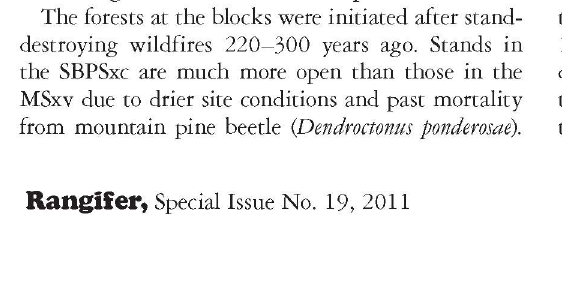
subzones, lodgepole pine is the dominant tree spe¬ cies and undergrowth is low growing. Kinnikinnick (Arctostaphylos uva-ursi) and pinegrass (Calamagrostis rubescens) in the SBPSxc are replaced by crowber- ry (Empetrum nigrum), twinflower (Linnaea borealis), grouseberry (Vaccinium scoparium), and feathermosses (mostly Pleurozium schreberi and Dicranum spp). A rich variety of lichens, especially Cladonia spp., occur in both subzones. In all blocks, herbs such as north¬ western sedge (Carex concinnoides) and bunchberry (Cornus canadensis) occurred in low abundance (1 to 2%). Soopalallie (Sheperdia canadensis) grows in small patches throughout the study area, while common juniper (Juniperus communis) was the most abundant shrub in the